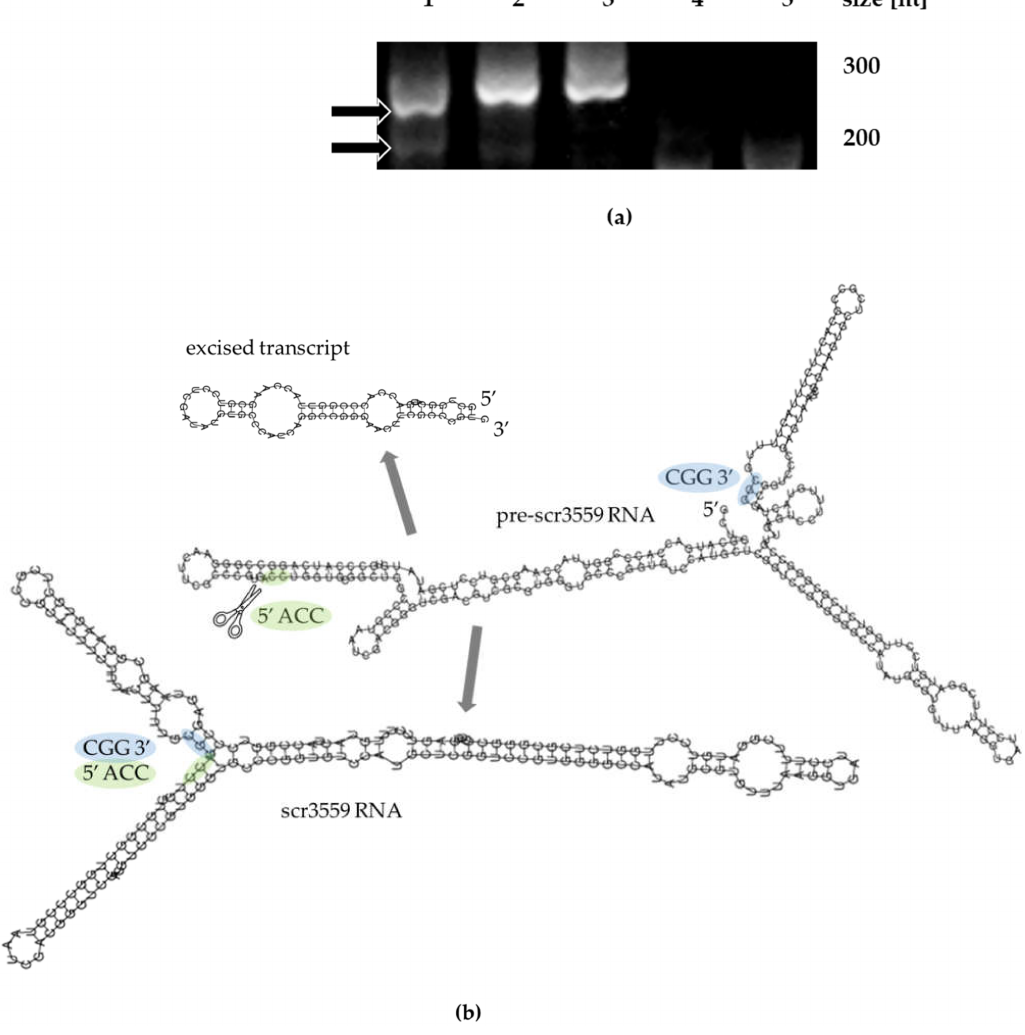
Figure 2. ( a ) 5 (cid:48) RACE analysis. From the left: lanes 1–3 PCR products from the RACE experiment, taken from 72, 144, and 168-h-old cultures; lanes 4–5 RTase-free and ligase-free negative controls (no signals). The arrows point to those PCR products whose sequences correspond to the nascent scr3559 RNA (260 bases) and to the processed form (192 bases). The molecular sizes of the RACE-generated PCR products roughly corresponded to the sizes of the whole transcripts. ( b ) Secondary structure predictions for the 260 nt pre-scr3559 RNA, a processed 192 nt form and the excised 68 nt transcript. The structures were modeled using RNAfold software with energy parameters scaled to 30 ◦ C. The scissors mark the predicted site of cleavage in the precursor transcript. The green and blue clouds indicate the 5 (cid:48) and 3 (cid:48) ends of scr3559 RNA,